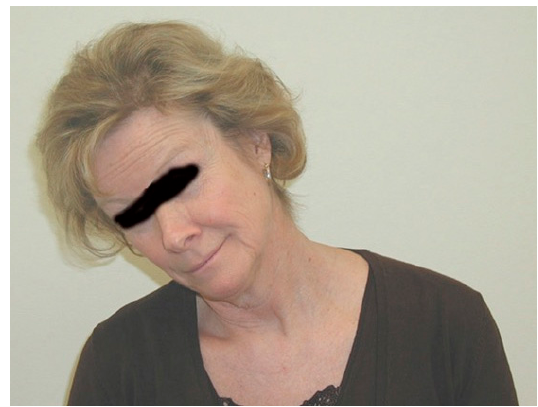
Figure 4. Head tilt, ear to shoulder.